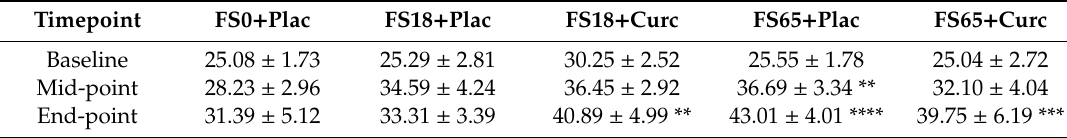
Table 3. Mean ferritin ( µ g / L) values (low ferritin sub-group) per treatment group and timepoints (mean ± SEM). * represents significance values when comparing mid-point or end-point to baseline within the same condition (** p < 0.01; *** p < 0.001; **** p < 0.0001).